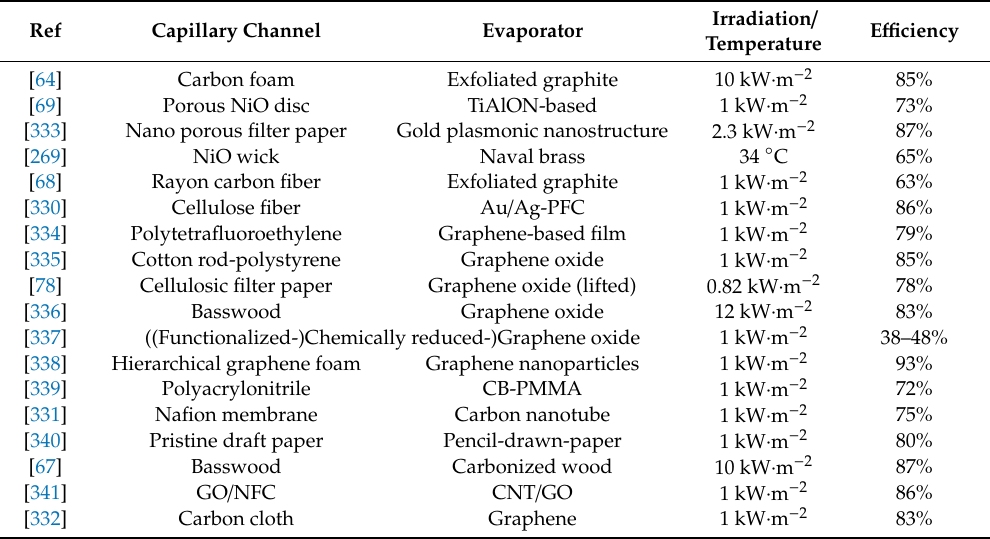
Table 4. E ffi ciency of CDD / CDWA Table 4. Efficiency of CDD/CDWA systems .